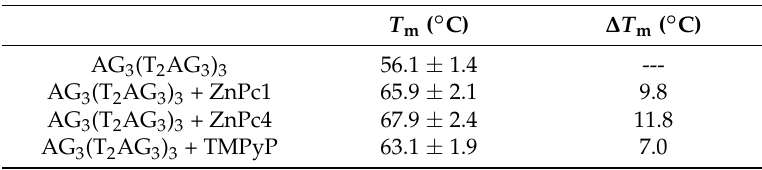
Table 5. CD melting temperatures ( n =